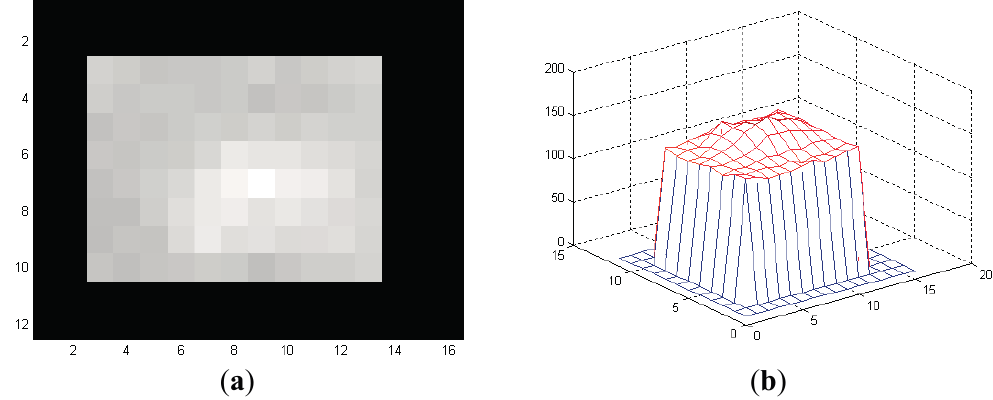
Figure 5. ( a ) A 12×16-pixel training image for classification filters created from the target patch of Frame 100 of L2018; and ( b ) 3D mesh plot of